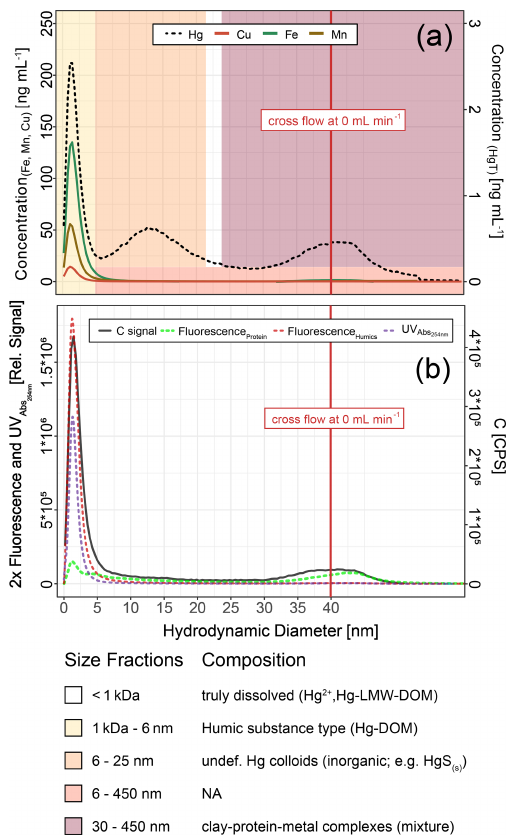
Figure 9. Hg, Cu, Mn and Fe concentrations (a) and C signals (ICP– MS) and UV254nm absorbance and fluorescence signals (b) in col- loids as a function of hydrodynamic diameter (related to retention times on AF4) in a sample from HMLC at day 9 after flooding. These fractograms were obtained at linearly decreasing crossflow from 2 to 0mLmin − 1 over 20min. The red line indicates the time point where the crossflow reached 0mLmin − 1 . Areas (yellow to red color) indicate size fraction ranges assigned during deconvolu- tion.